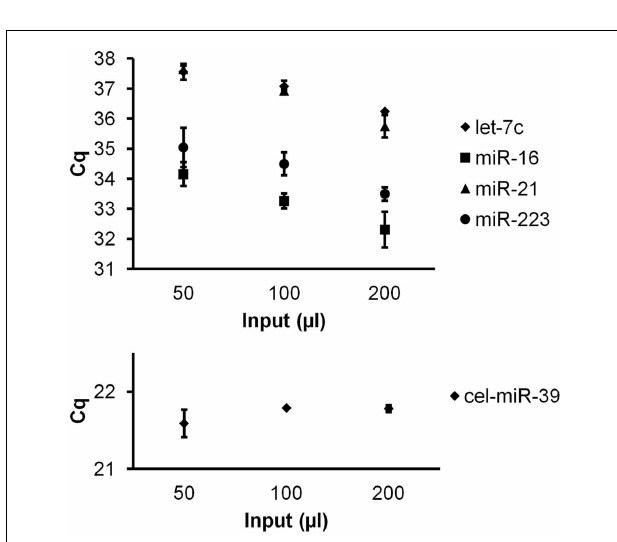
FIGURE 4 | Quantitative recovery of RNA from plasma does not extend to highest input volume .The Exiqon Biofluids kit was used to isolate RNA in duplicate isolations for each of the three indicated quantities of plasma.